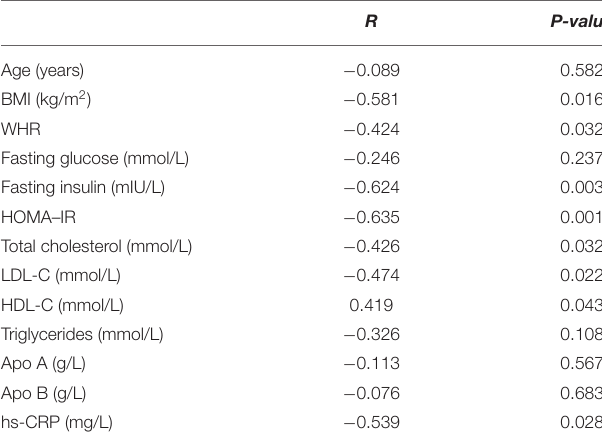
TABLE 3 | Correlation of serum 25(OH)D concentration with metabolic parameters in PCOS women.